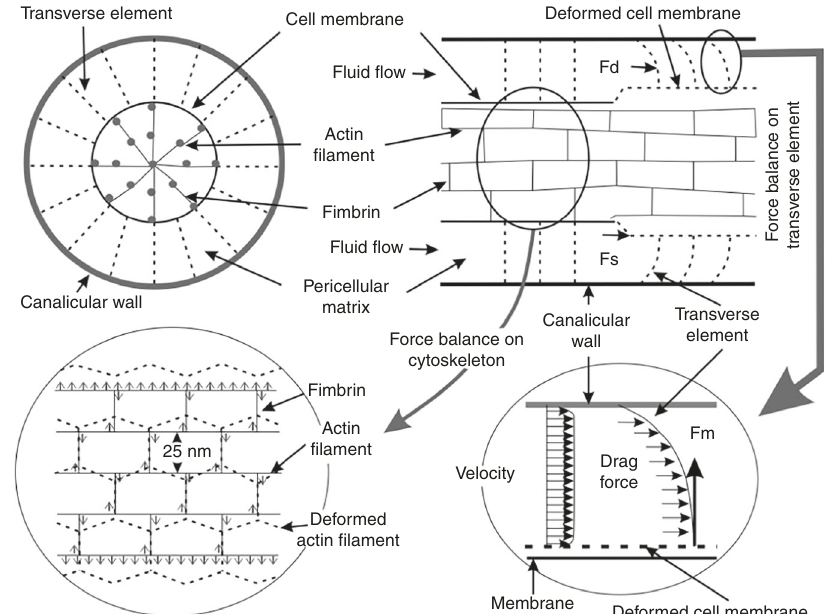
Fig. 6 Schematic model showing the structure of the pericellular matrix, the intracellular actin cytoskeleton inside the process and the connection between the pericellular matrix and the intracellular actin cytoskeleton 17 . Figures adapted with permission from ref. 17